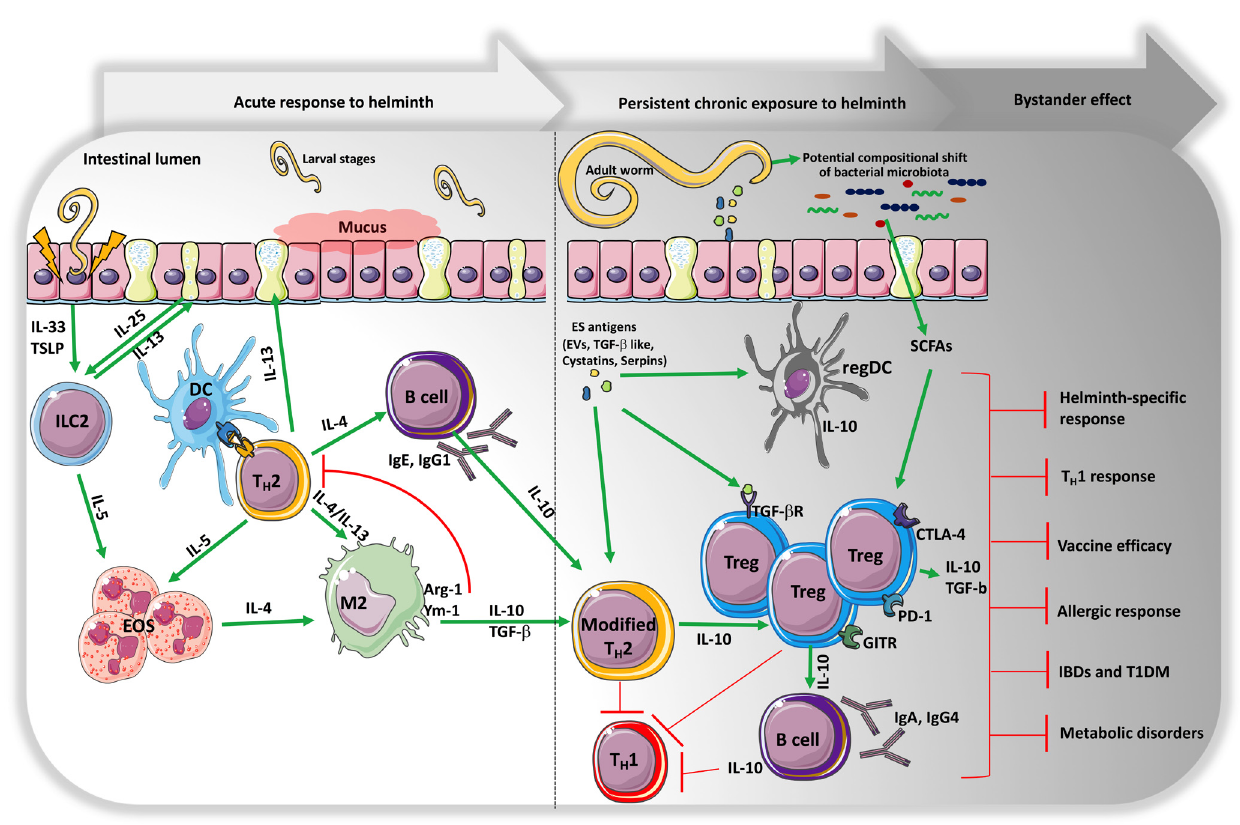
Figure 1. Acuteness and chronicity of helminth infection drive distinct immune profiles. Early in infection, normally during the larval migration through the lungs or intestinal mucosa, prior to adult worm development and establishment, epithelial cells secrete a group of alarmins—thymic stromal lymphopoietin (TSLP) and interleukin-33 (IL-33), including IL-25-producing tuft cells—that promote the activation and differentiation of type 2 innate lymphoid cells (ILC2) and polyfunctional CD4 T helper 2 (Th2) cells, leading to the secretion of a